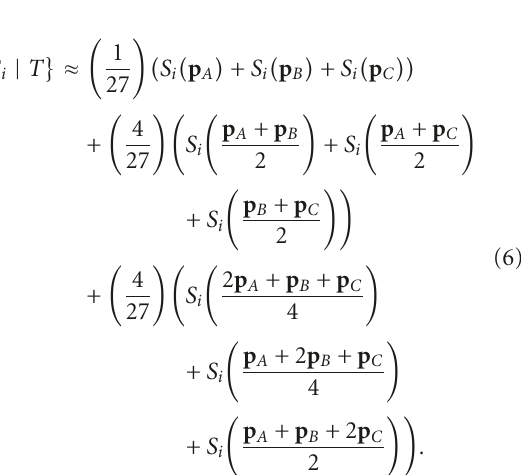
Figure 2: A local basis for a triangle in